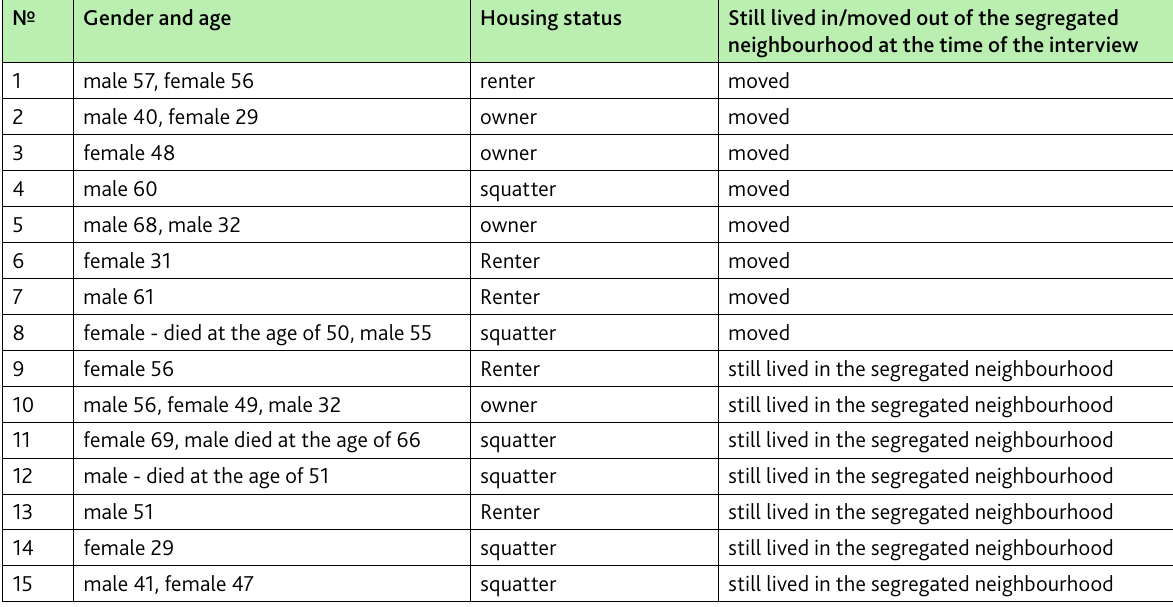
Table 1. Housing status and demographic characteristics of the interviewees № Gender and